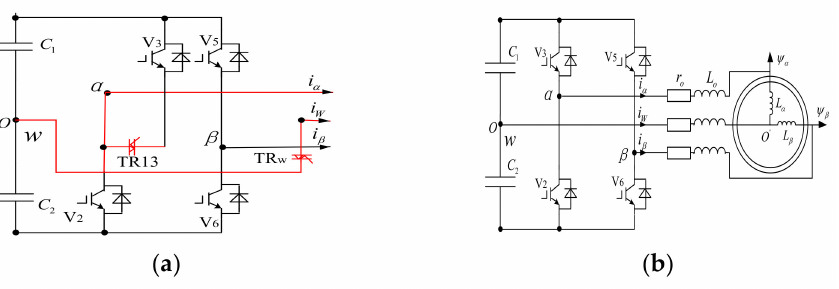
Figure 4. Inverter reconstruction process when V 4 fails. ( a ) Switching process; ( b ) Reconstruction